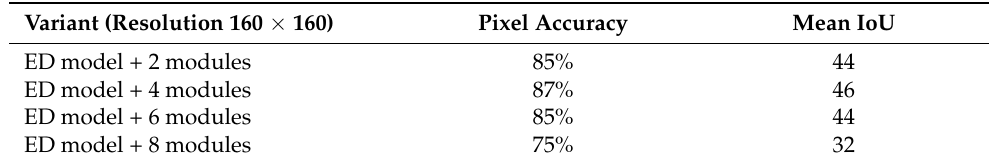
Table 8. Results of the architecture with transfer learning on Pascal VOC 2012 dataset (image resolution 160 ×